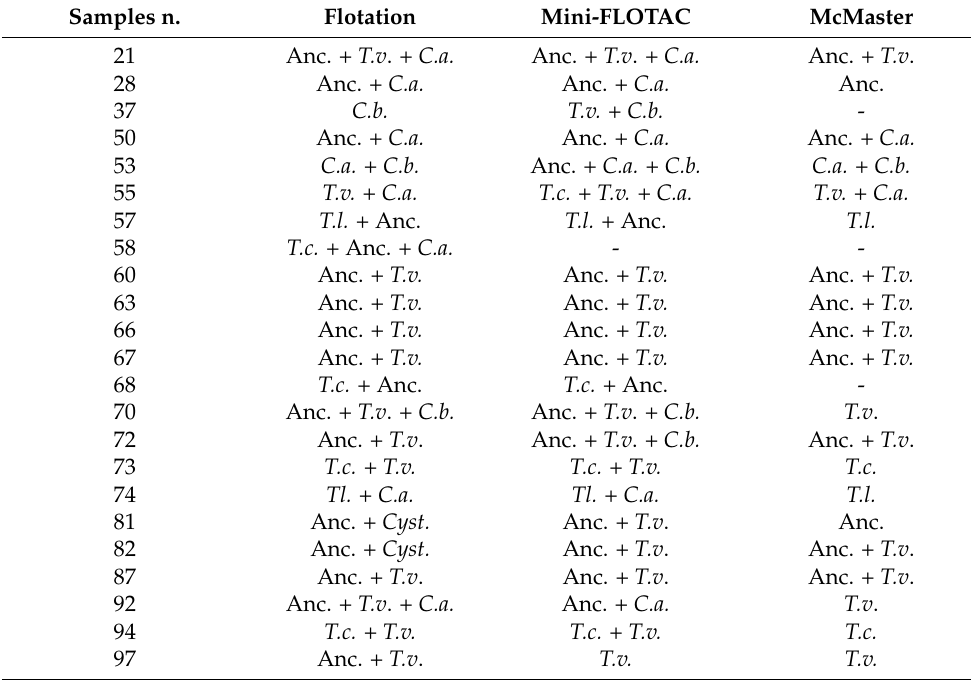
Table 5. Species detected by each technique in co-infected dogs. Samples n.